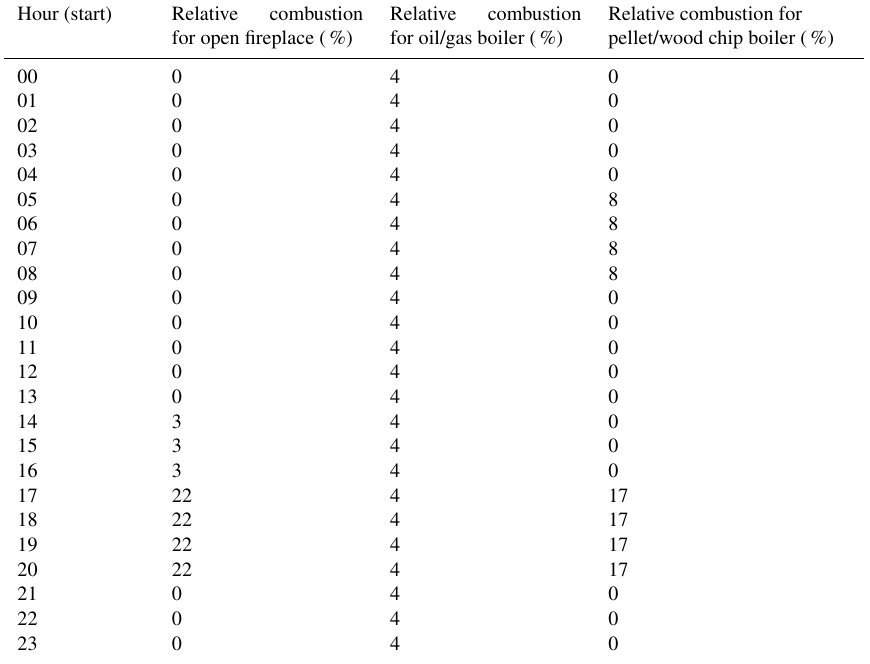
Table A6. Share of total daily combustion used in emission inventory for open fireplace, oil/gas boiler and pellet/wood chip boiler.